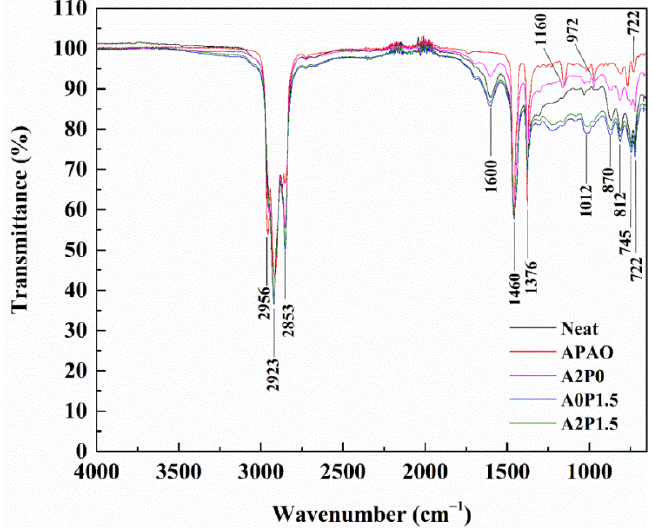
Figure 17. Infrared spectra of tested samples.